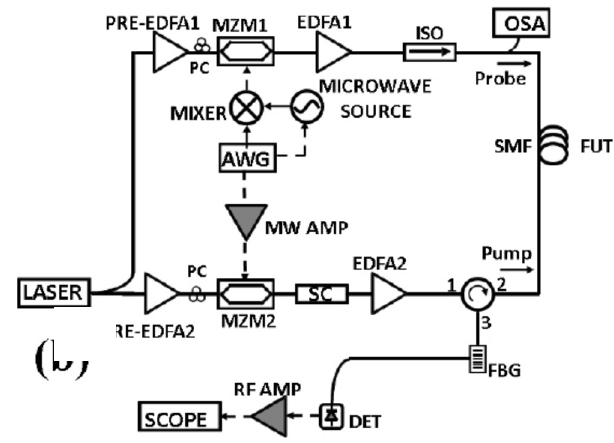
Figure 17. Experimental setup employed for sweep-free BOTDA measurements [63].